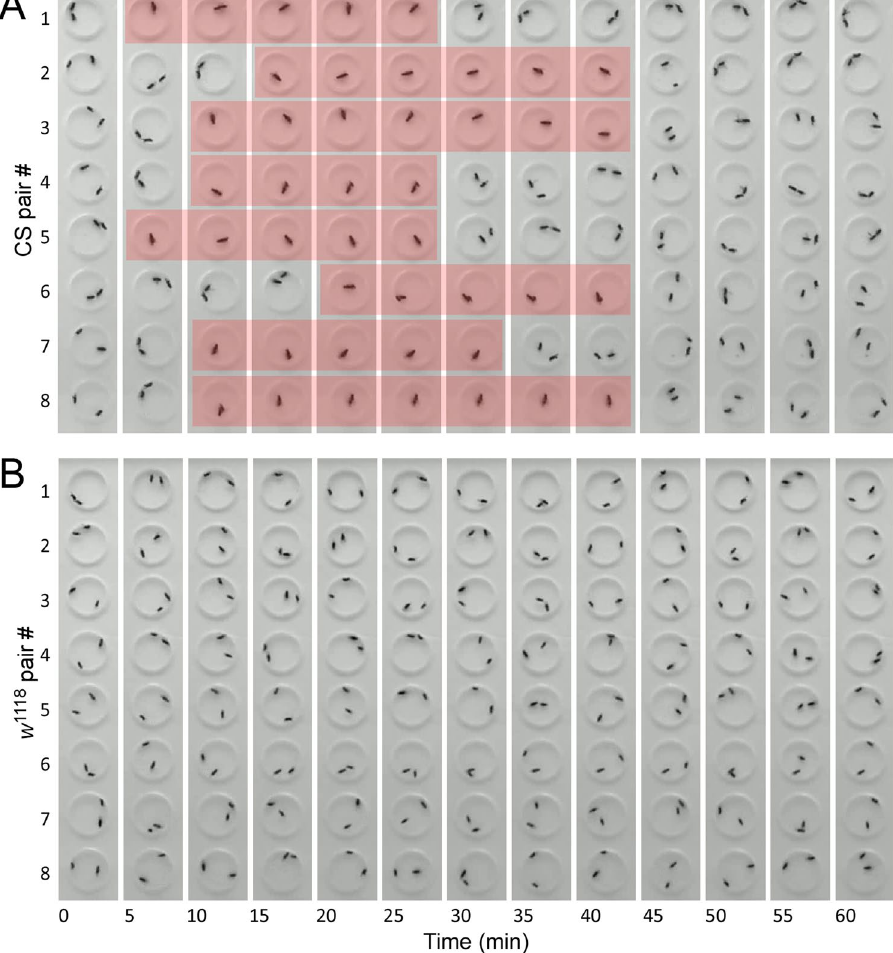
A defect of copulation success in w mutants. When a naive CS male (4-day-old) and a virgin CS female (4-day-old) were placed into a circular arena (1.27 cm diameter and 0.3 cm depth), they initiated courtship activ- ities and started copulation (flies in copulo) within minutes. Such a sexual interaction was highly consistent from one pair to another (Fig. 1A). In the w mutant w 1118 , however, a naive male and a virgin female together rarely initiated typical courtship activities and failed to copulate within 60 min. The failure of copulation in w 1118